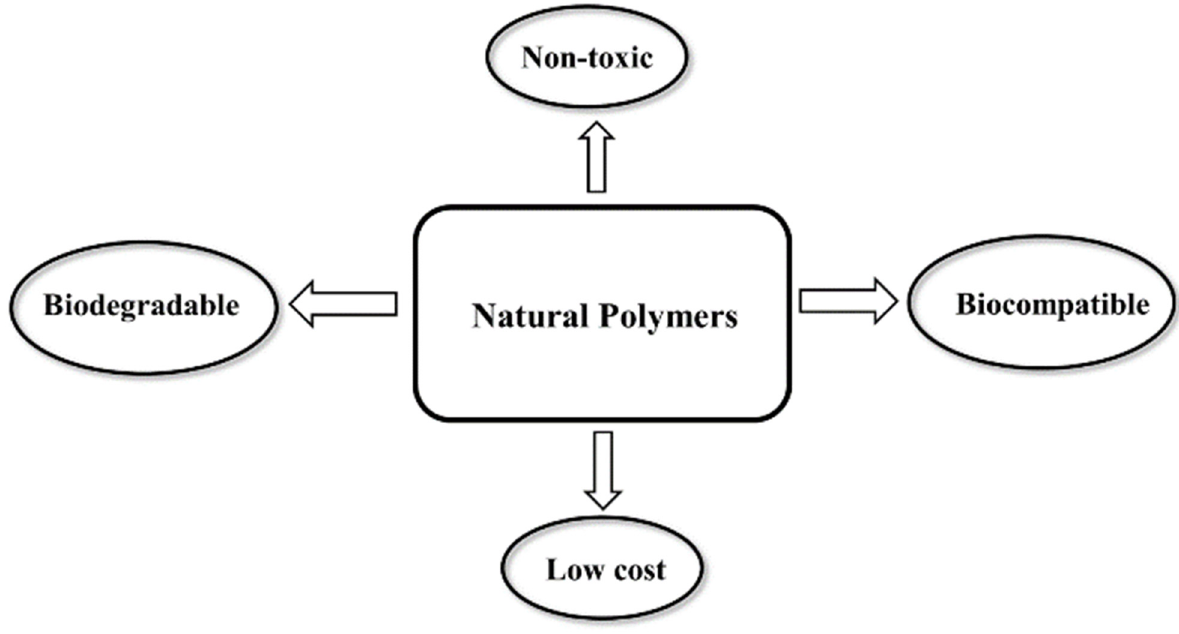
Figure 2. Key benefits of natural polymers as antiviral materials.